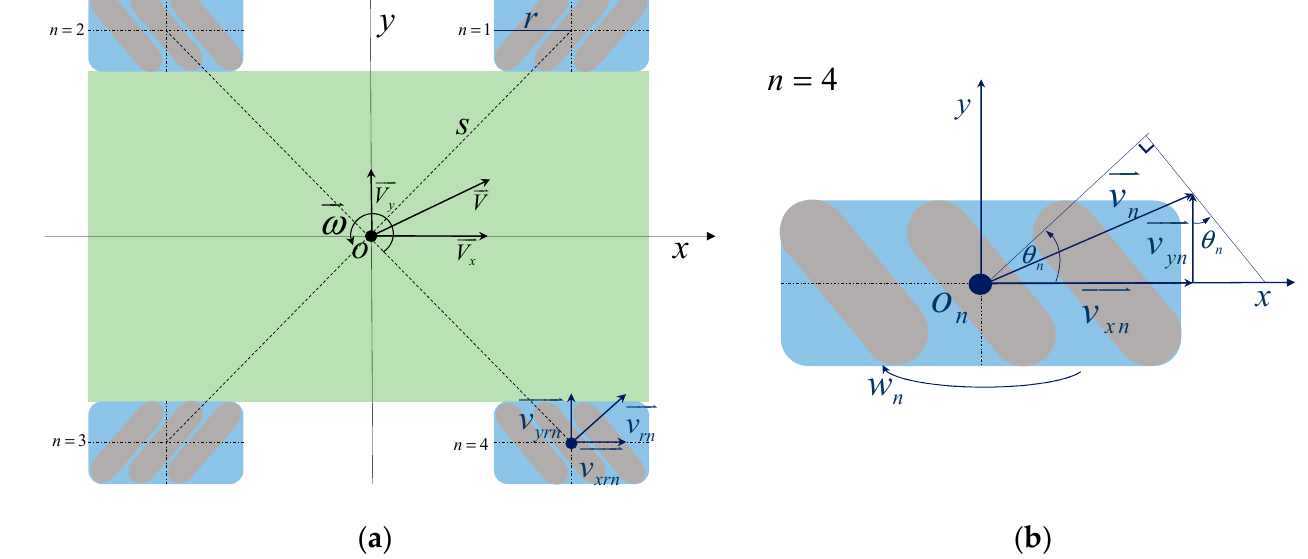
Figure 3. Motion decomposition diagram of chassis: ( a ) integral decomposition of chassis; ( b ) motion decomposition of a single wheat wheel.